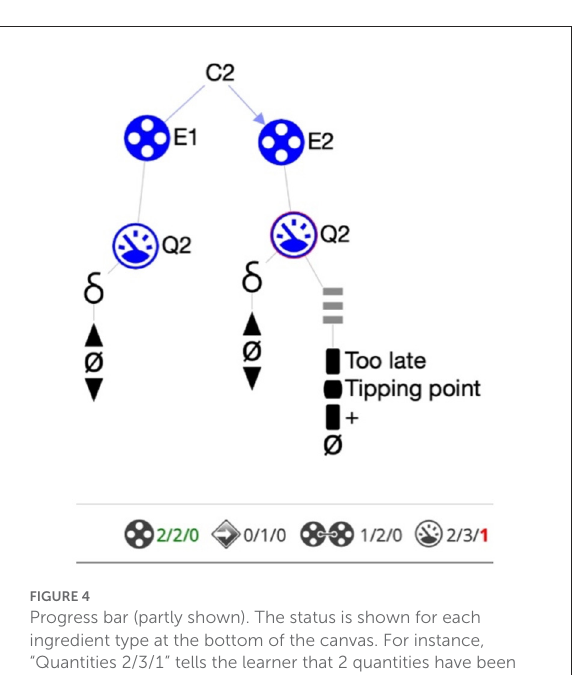
FIGURE4 Progress bar (partly shown). The status is shown for each ingredient type at the bottom of the canvas. For instance, “Quantities 2/3/1” tells the learner that 2 quantities have been created, 3 need to be created in total and that 1 is currently incorrect (shown in red). When all ingredients have been created correctly the numbers become green, as for entities here.